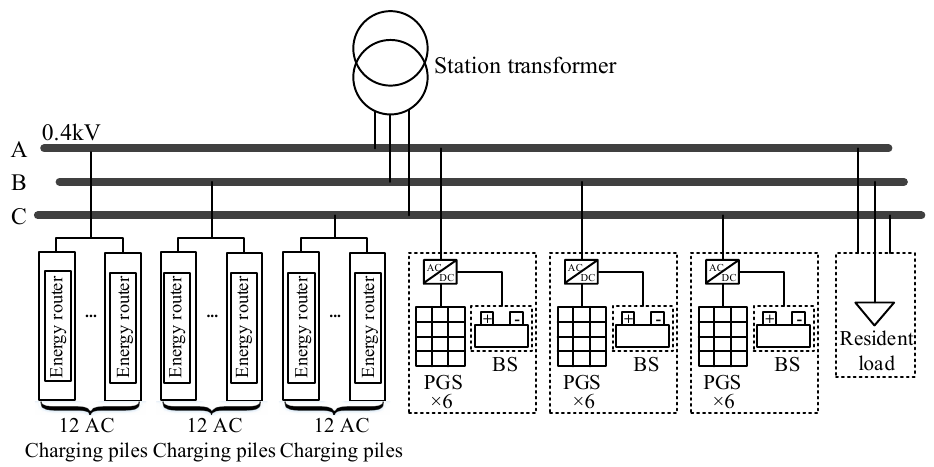
Figure 5. Community wiring diagram.